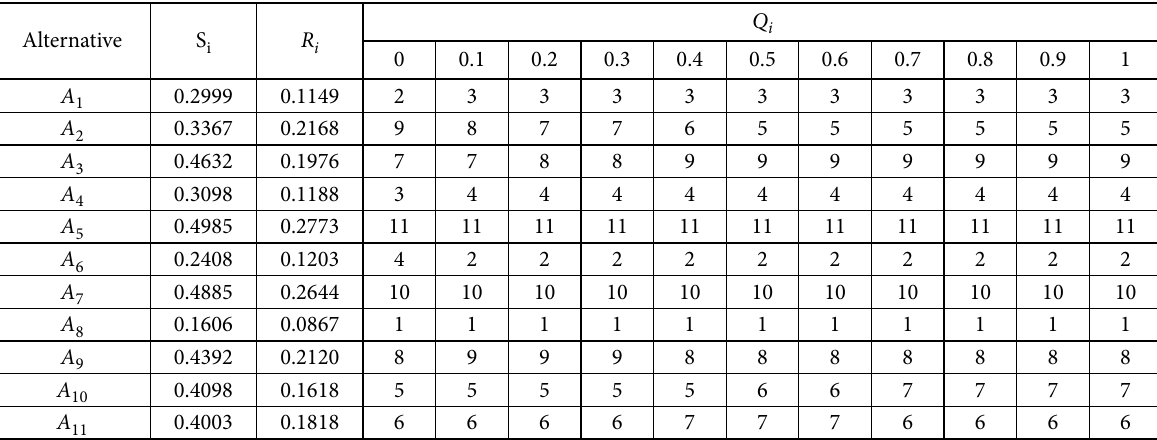
Table 5. S i , R i and Q i values for different